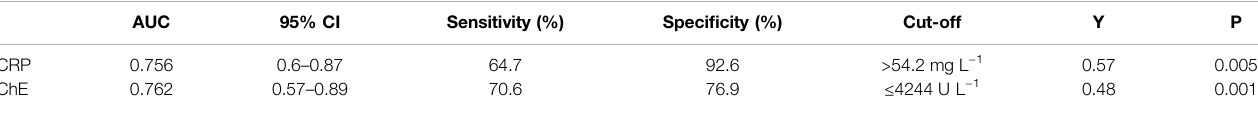
TABLE 3 | ROC curve parameters for systemic in fl ammation prediction in extensive and intermediate metabolizers. CRP, c-reactive protein; ChE,cholinesterase; AUC, area under the curve; CI, con fi dence interval; Y,Youden ’ s